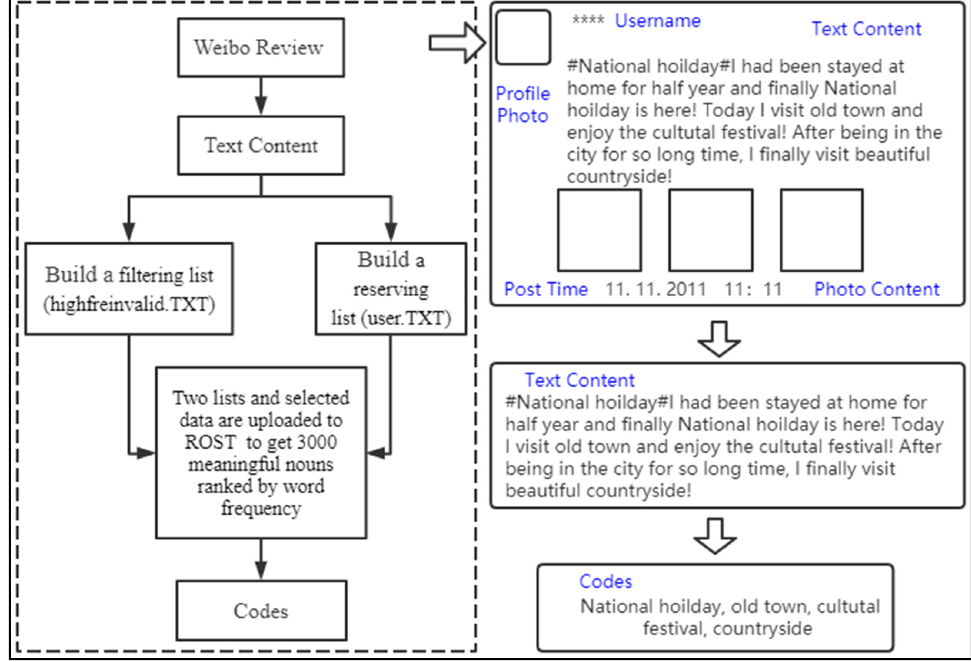
Figure 2. Weibo data preprocessing